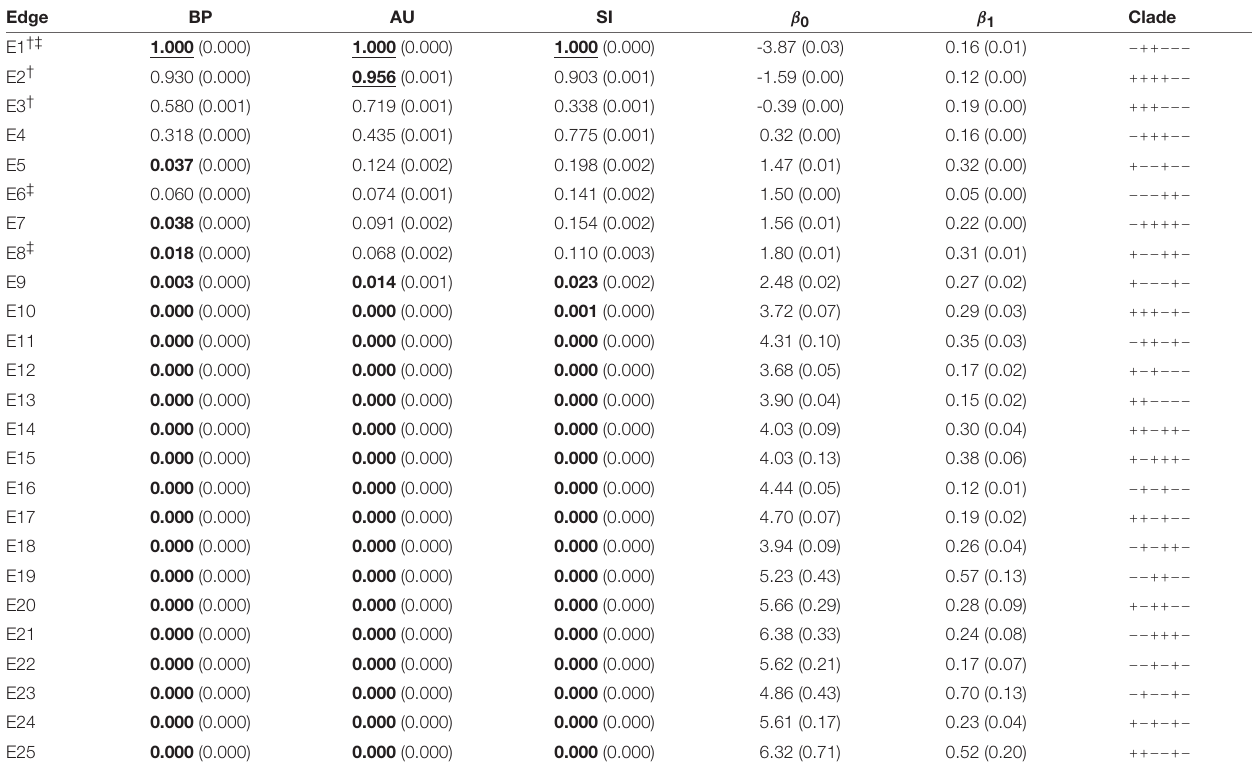
TABLE 2 | Three types of p -values (BP, AU, SI) and geometric quantities ( β 0 , β 1 ) for all the 25 edges of six taxa.